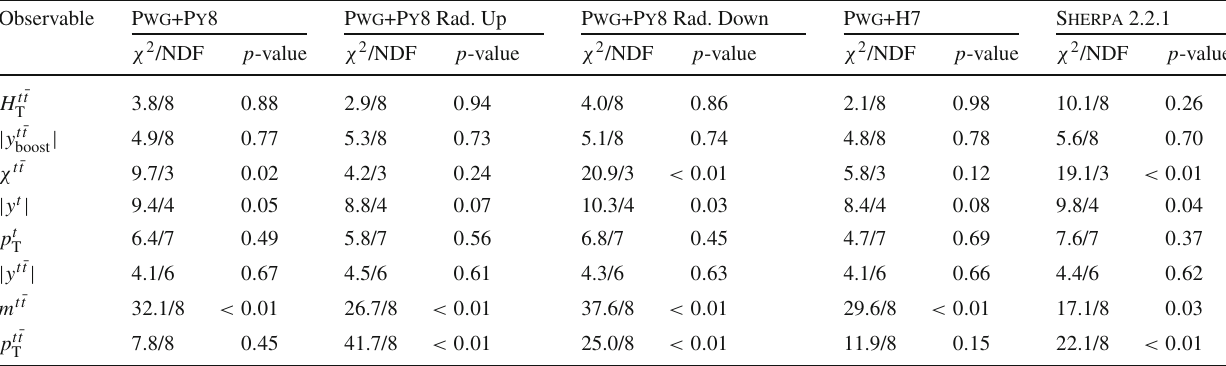
Table 17 Comparison of the measured parton-level normalised single- differential cross-sections in the resolved topology with the predictions from several MC generators. For each prediction a χ 2 and a p -value are